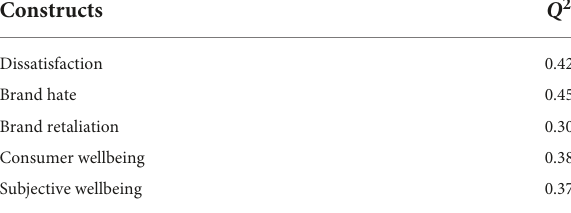
TABLE 8 Blindfolding analysis ( Q 2